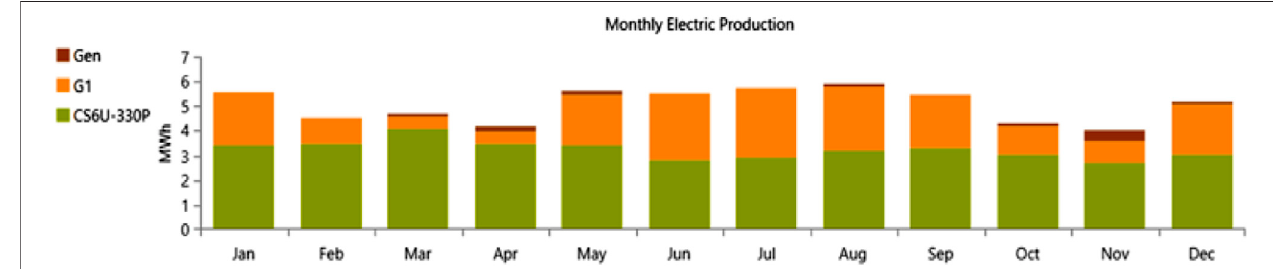
FIGURE 8 | Monthly electricity production from solar, wind, and diesel generators